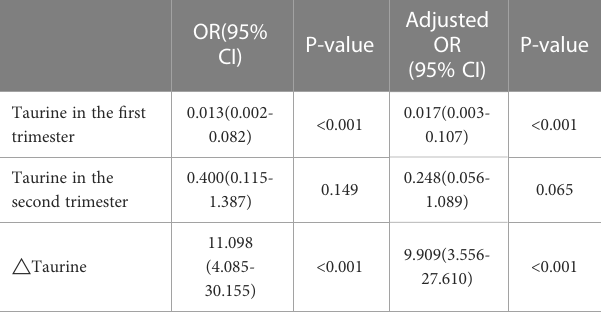
TABLE 3 The relationship between Taurine and